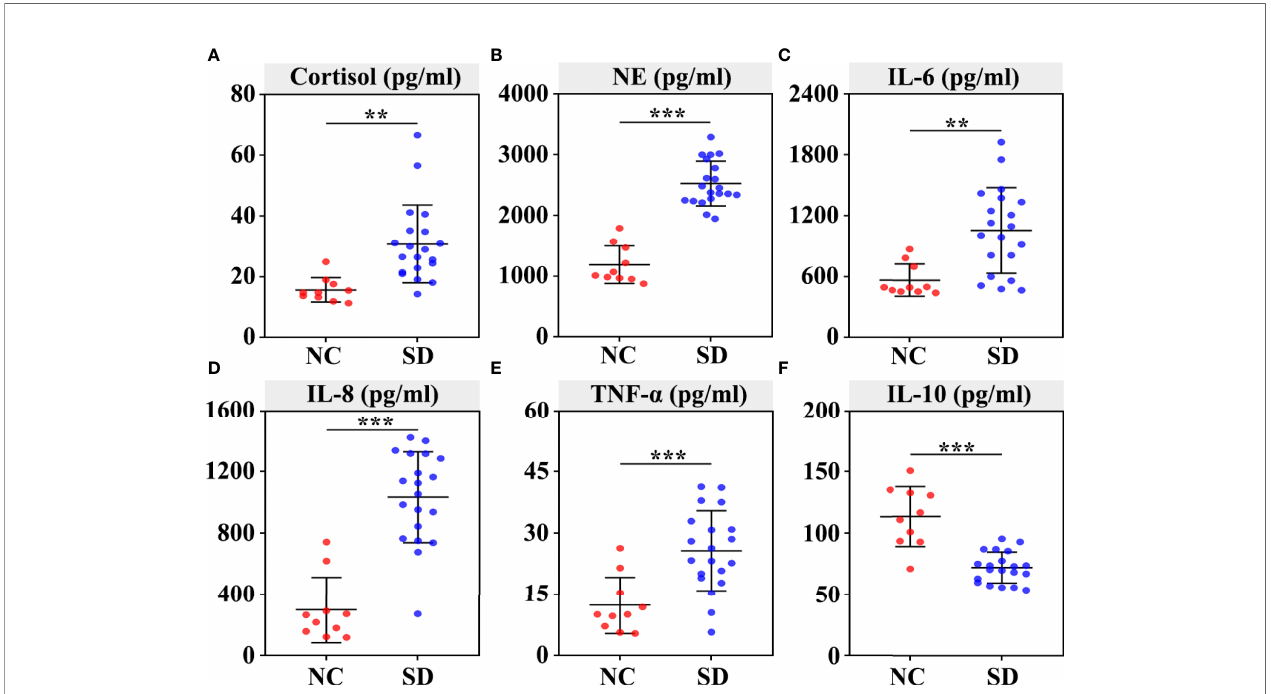
FIGURE 1 | Effects of sleep deprivation (SD) on the secretion of stress hormones and in fl ammatory cytokines in rhesus monkeys. The plasma was extracted from the centrifuged blood samples after 30 days of sleep deprivation. The concentration of serum cortisol (A) , norepinephrine (B) , IL ‐ 6 (C) , IL-8 (D) , TNF ‐ a (E) , and IL ‐ 10 (F) was detected using ELISAs. Differences were denoted as follows: ** p < 0.01; *** p < 0.001. NC, normal control